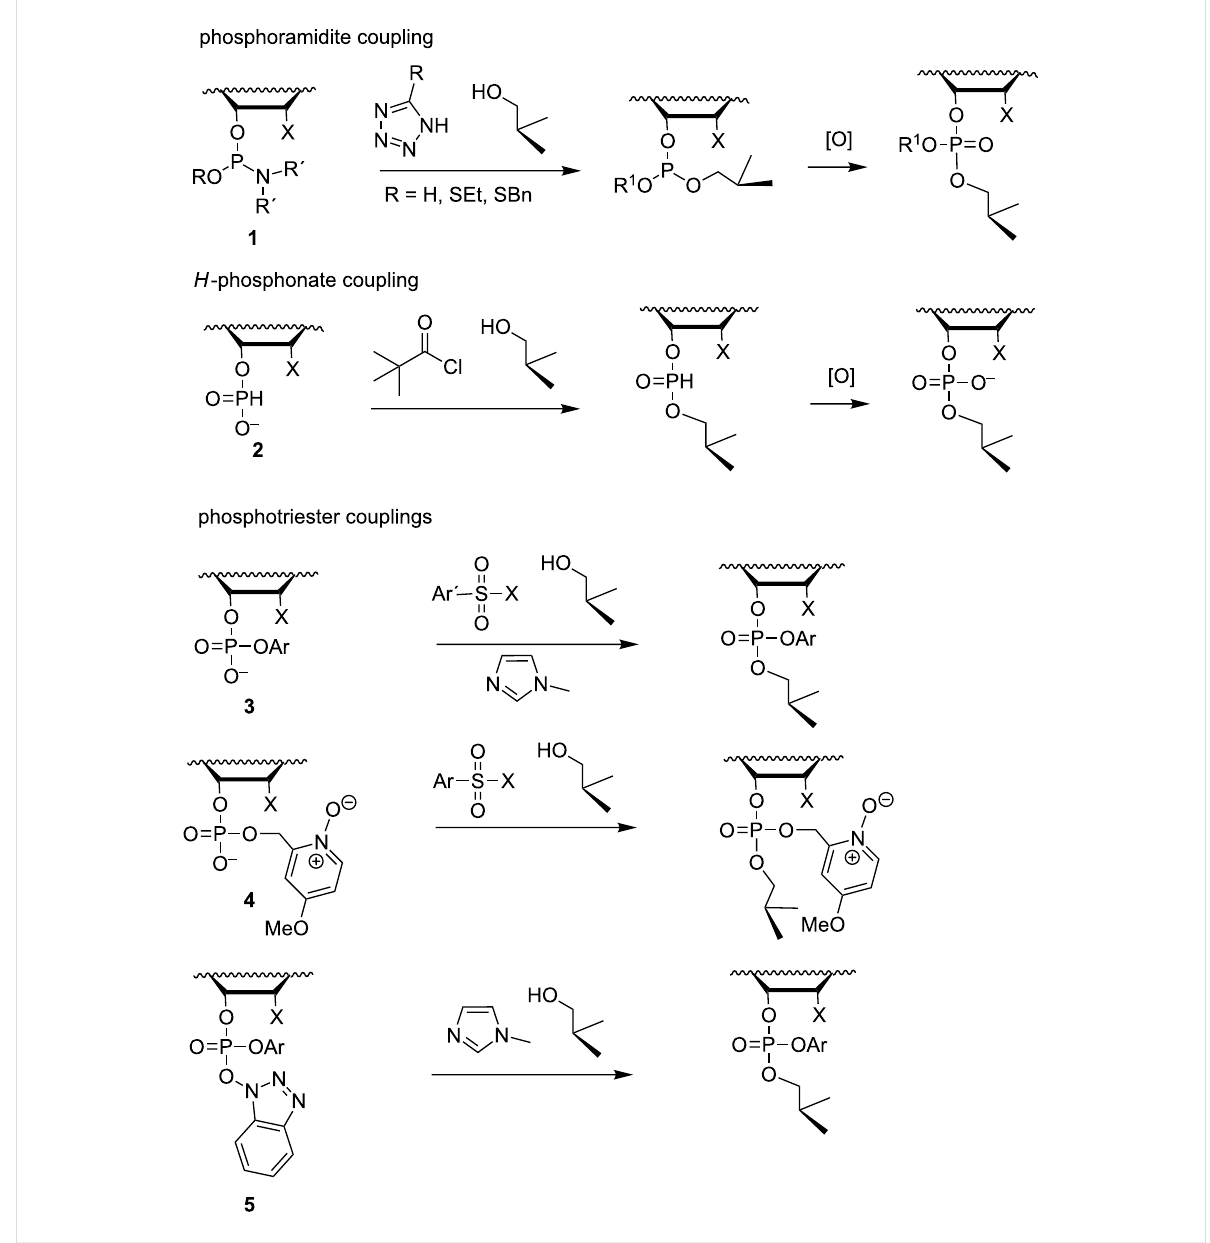
Scheme 1: Alternative coupling methods used in the synthesis of oligonucleotides.